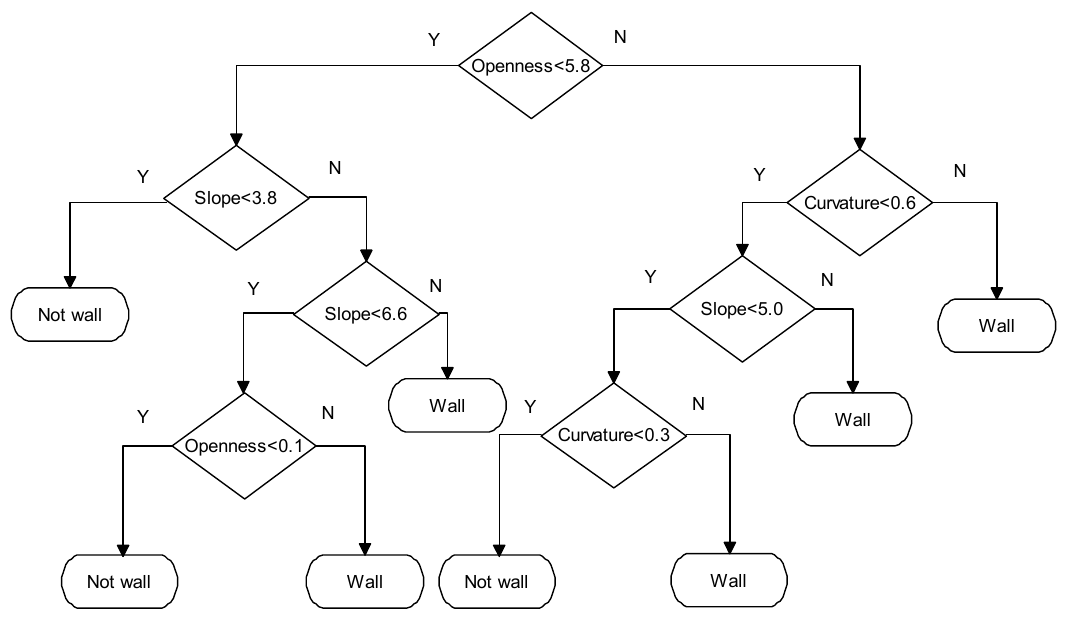
Figure 8. Classification rules of low wall features.